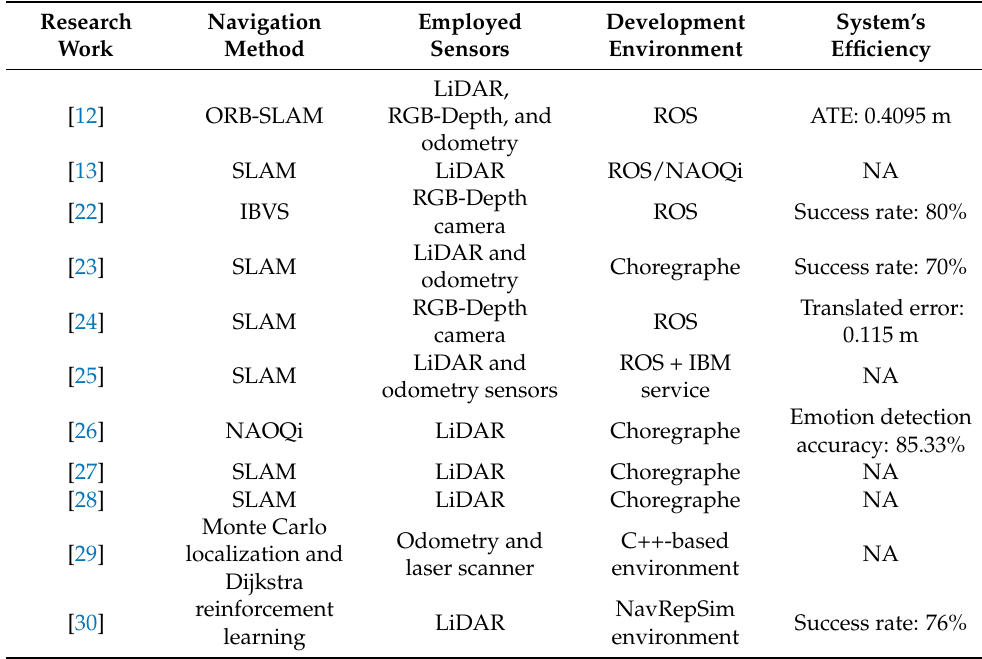
Table 1. A comparison between Pepper robot navigation